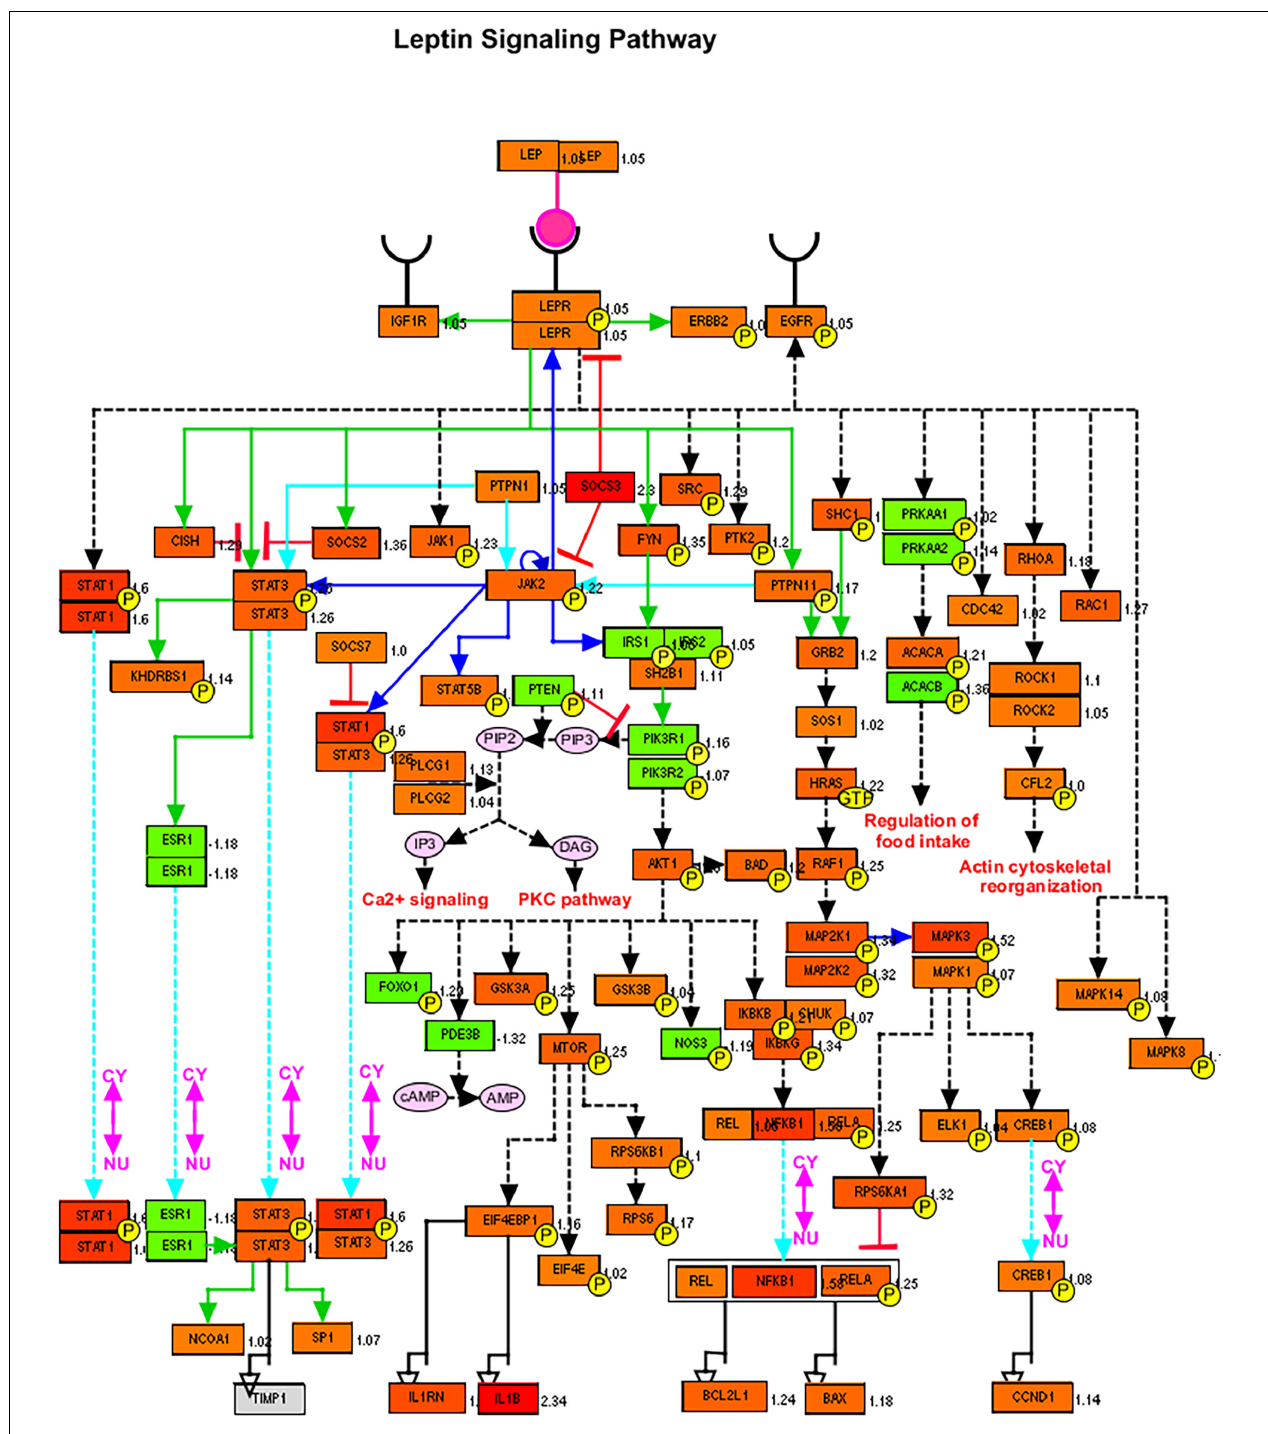
FIGURE 4 | Leptin signaling pathways genes members and their expression in SARS-CoV-2 infected epithelial cells versus non-infected. Red color signifies upregulation in infected cells, and green signifies downregulation as generated by PathVisio software.